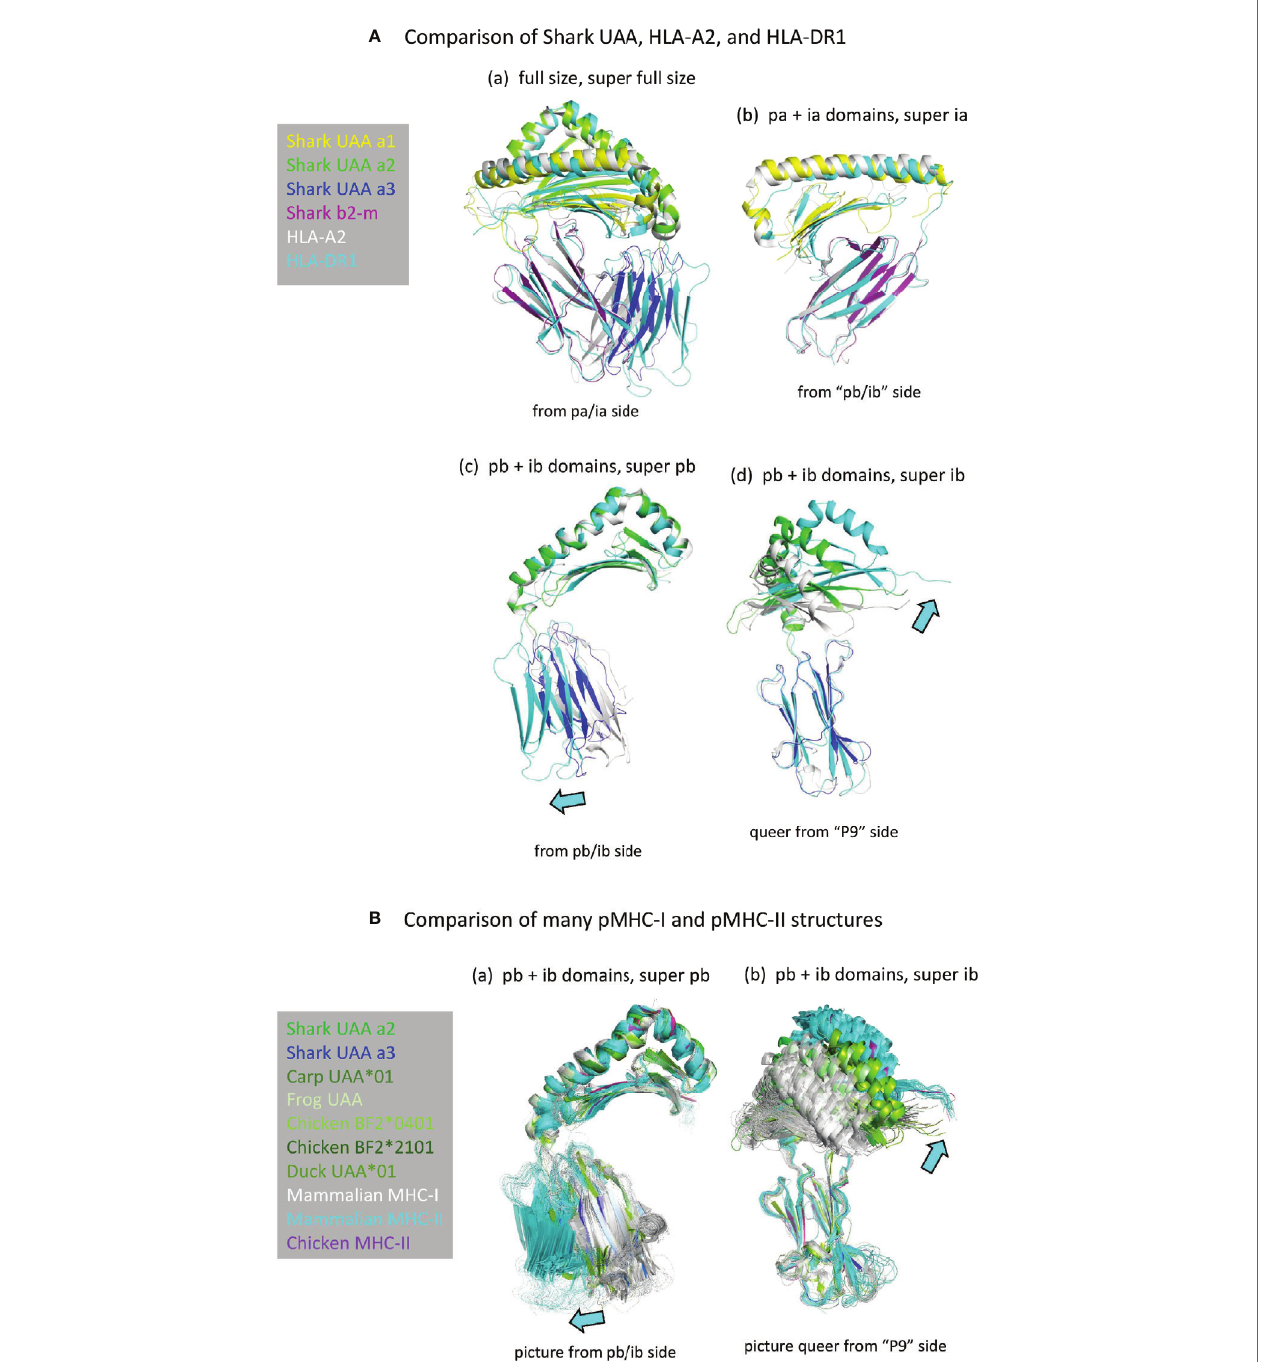
FIGURE 4 | (A) Comparison of domain orientations in pMHC-I and pMHC-II. The description “ super ” relates to the super function of PyMOL software that was used for superimposing the indicated domain. (A a ) Superposition of the full size pMHC ectodomain structures (shown without peptide) of shark pUAA (colored per domain), pHLA-A2 (gray), and pHLA-DR1 (cyan) reveals the largest orientation differences in the ib (I- a 3 and II- b 2) domains, with shark pUAA ib taking an intermediate position. By separate analysis of the pa+ia and pb+ib domains, it is easily seen that the pa+ia domain orientations are very similar between the different pMHC molecules ( A b), whereas there are considerable differences in the ib to pb angles ( A c, A d). In ( A c, A d), cyan arrows highlight the directions in which respective pHLA-DR1 domains differ from the corresponding pHLA-A2 domains. (B) Figures ( B a, B b ) are as ( A c, A d), except that they compare many more pMHC-Is (gray for mammals, green or dark blue for primitive vertebrates) and pMHC-IIs (cyan for mammals, purple for chicken), revealing an overlap between the range of ib domain orientations in pMHC-Is of primitive vertebrates and